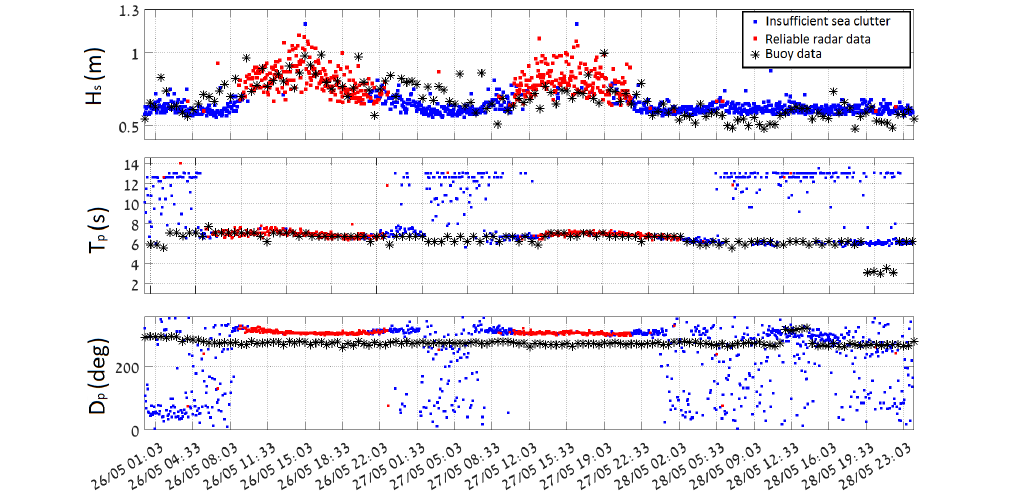
Figure 3. Comparison of the radar image sequence derived sea state parameters ( H s , T p , D p ), calculated for the analysis box 2 (see the box definition in Figure 4) and the corresponding wave rider buoy measurements for the mention period of 26–29 May 2018 (times are given in UTC). Streak filtration procedure is not introduced to the preprocessing. Reliable data and insufficient sea clutter radar data are marked based on the inner WaMoSII quality control